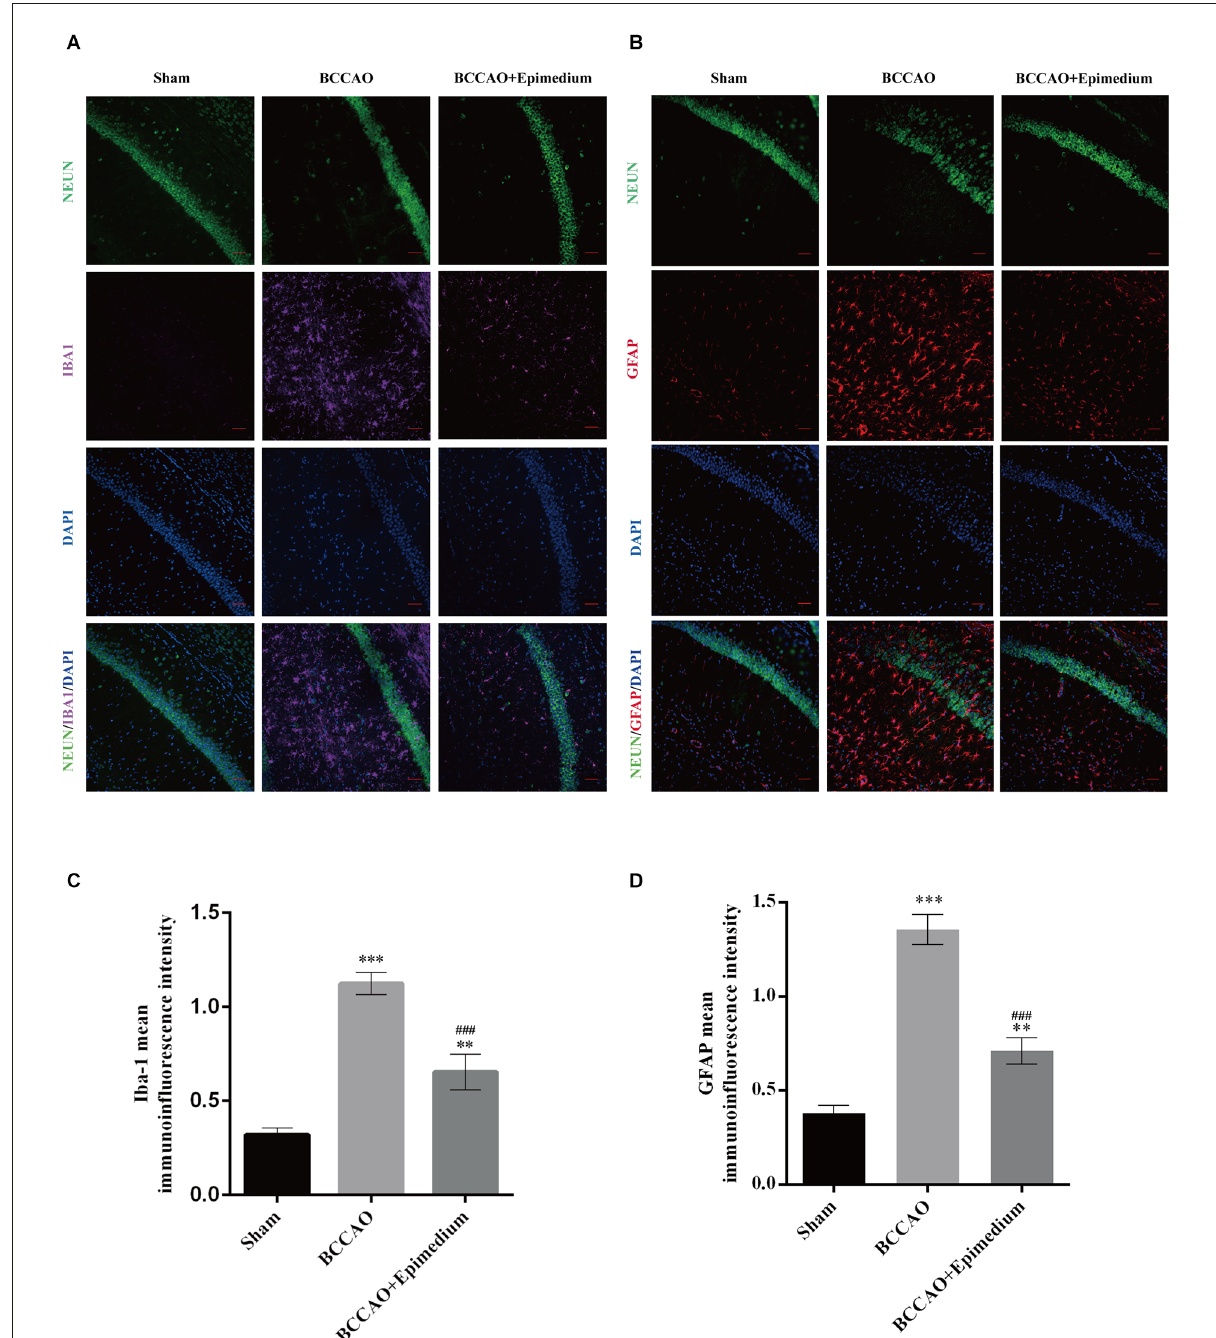
FIGURE11 Epimedium alleviated the activation of microglia and astrocytes in the hippocampus in VaD mice. Immunofluorescence was used to stain microglia and neuron (A) and astrocytes and neuron (B) . Panels (C) and (D) represent the quantitative analysis of the mean immunoinfluorescence intensity of Iba-1 and GFPA in each group (Scale bar = 50 µ m, n = 5). ∗∗∗ P < 0.001 and ∗∗ P < 0.01 vs. the sham group; ### P < 0.001 vs. the BCCAO group.